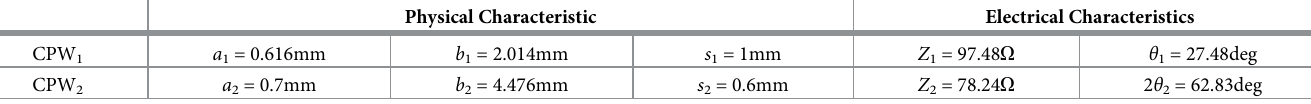
Table 1. Corresponding relationship between physical properties and electrical properties of